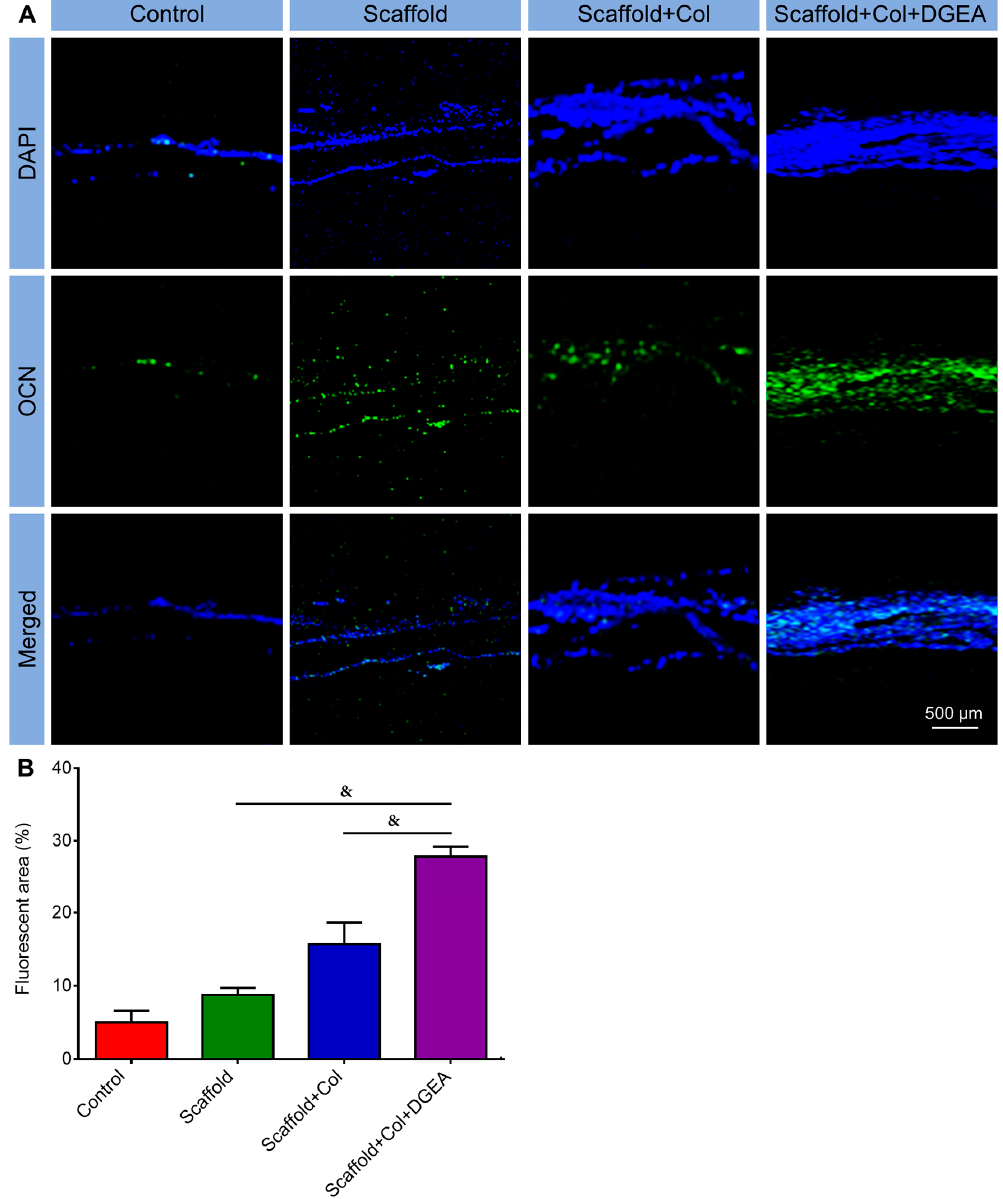
Figure 5. ( A ) Immunohistochemical and ( B ) semi-quantitative analyses of skull defect sites at 12 weeks post-implantation ( n = 3; & p < 0.001). The cell nucleus is blue labeled with DAPI, and OCN is green labeled with fluorescein isothiocyanate (FITC).